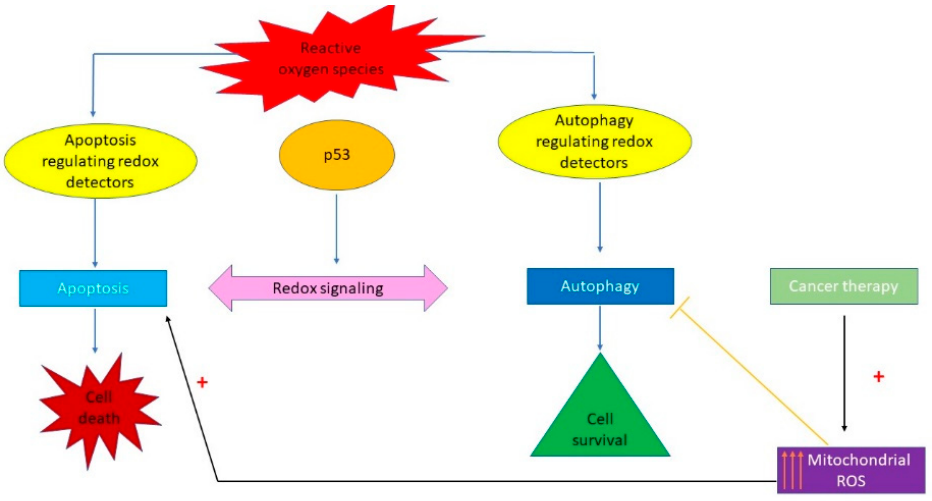
Figure 8. The redox-dependent control of the apoptosis–autophagy switch as an important target in anticancer strategy.